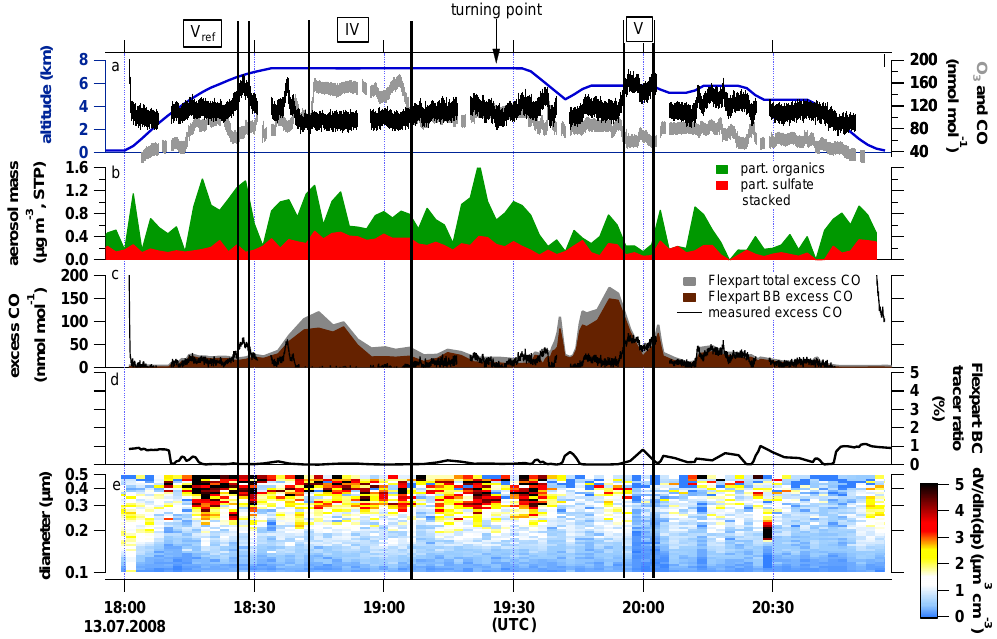
Fig. 4. 13 July 2008. (a) Aircraft altitude (blue) and trace gas mixing ratios (grey O 3 , black CO) in one second time resolution, the blue striped areas denote relative humidity equal to or greater than 100%. (b) AMS sulphate and organic aerosol mass concentration (stacked) in two minutes time resolution. (c) FLEXPART excess total and biomass burning (BB) CO and measured excess CO (actual concentration minus 100nmolmol − 1 ) , (d) ratio of FLEXPART BC aerosol-like and passive tracer, (e) SMPS volume size distribution at STP. The areas between the black bars with roman numbers indicate the discussed plumes.